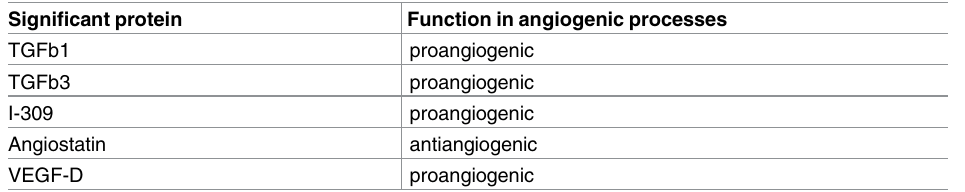
Table 3. Significant proteins–pro/anti angiogenic